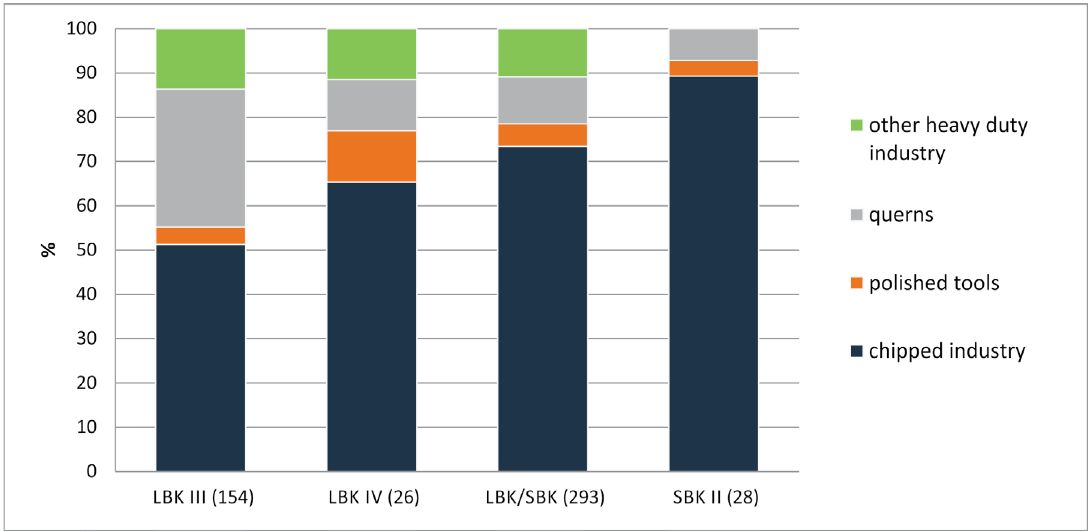
Figure 10. Basic categories of stone industry according to the chronological levels. Totals of determinations for each chronolo- gical level are represented in